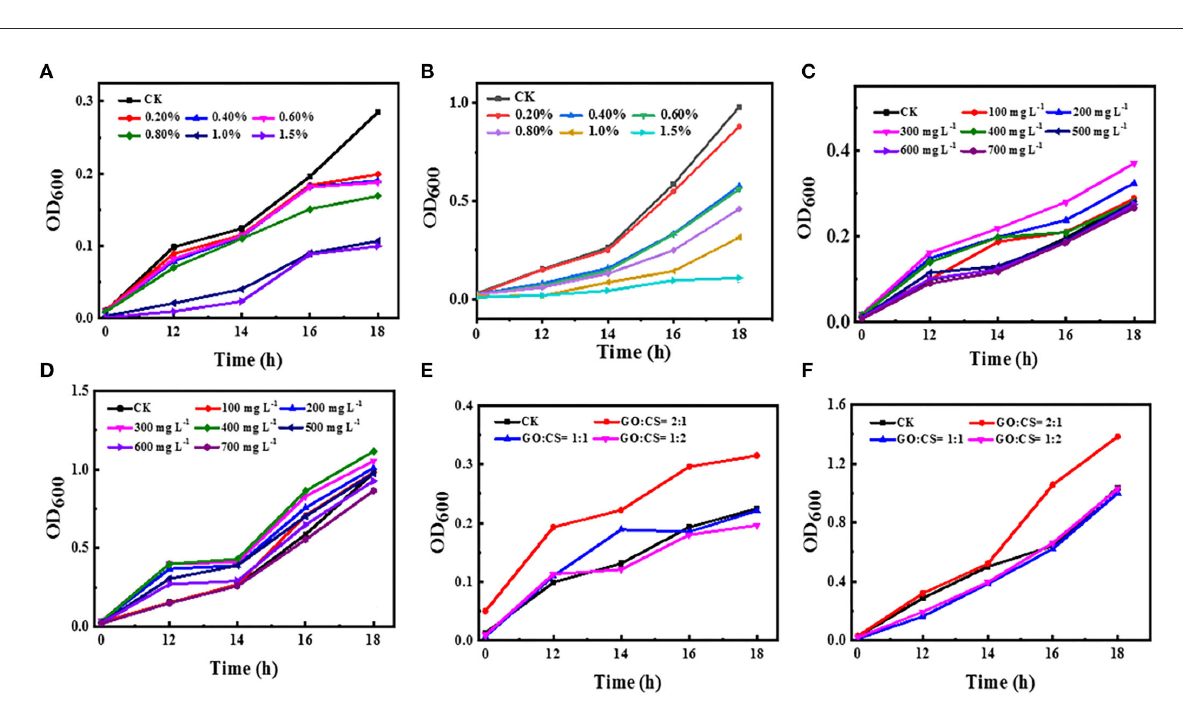
(Figures 2C,D). The OD value of the control group without graphene (CK) was initially 0.01 and 0.02 for BC and PAO1, respectively. After 18h of incubation, its value reached 0.285 and 0.980 for BC and PAO1, respectively. Unpredictably, with